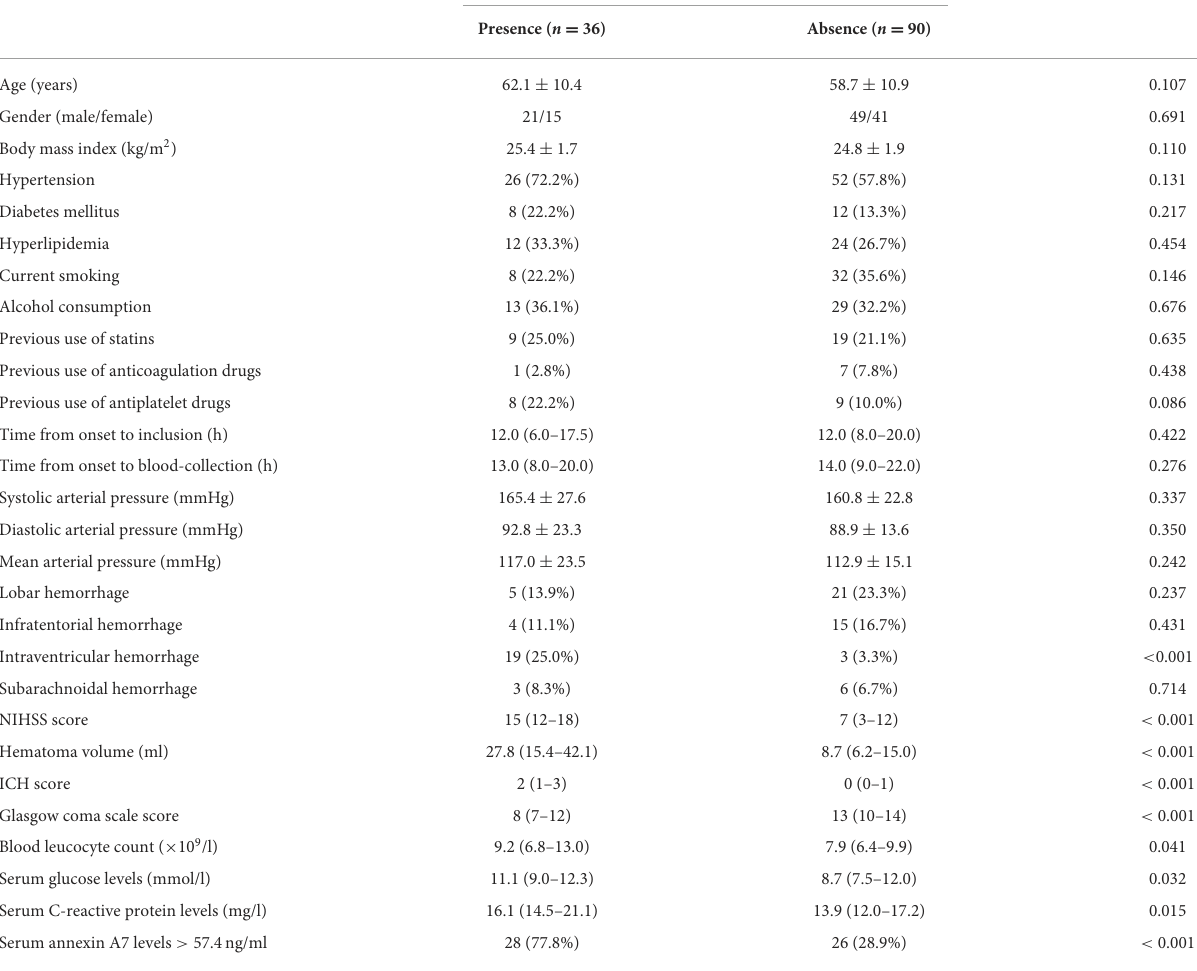
TABLE 2 Related factors of early neurological deterioration in acute intracerebral hemorrhage.